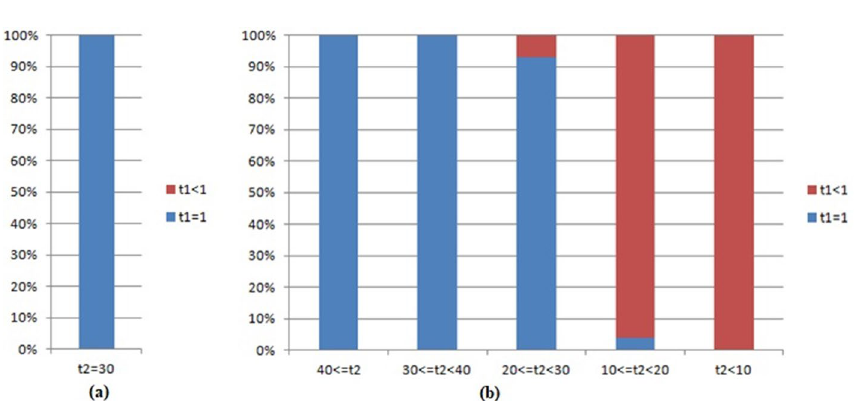
Figure 8. The proportion of the strings of pitches which are correctly identified in the all strings of pitches (a string of pitches is correctly identified, if the corresponding value of t1 is 1). ( a ) in Table 6; ( b ) in Table